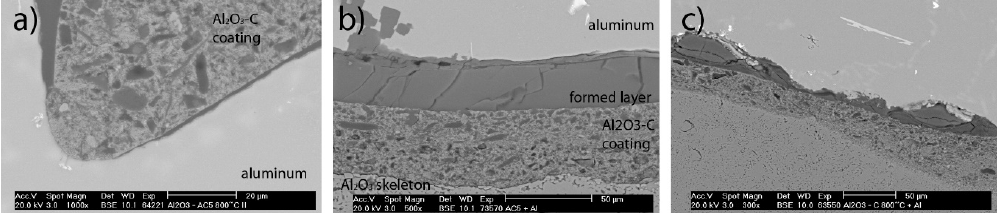
Figure 7. SEM micrographs of the ( a ) Al 2 O 3 -C 800 °C, ( b ) Al 2 O 3 -C 1400 °C and ( c ) Al 2 O 3 rough filters after casting of AlSi7Mg with non-metallic inclusion.